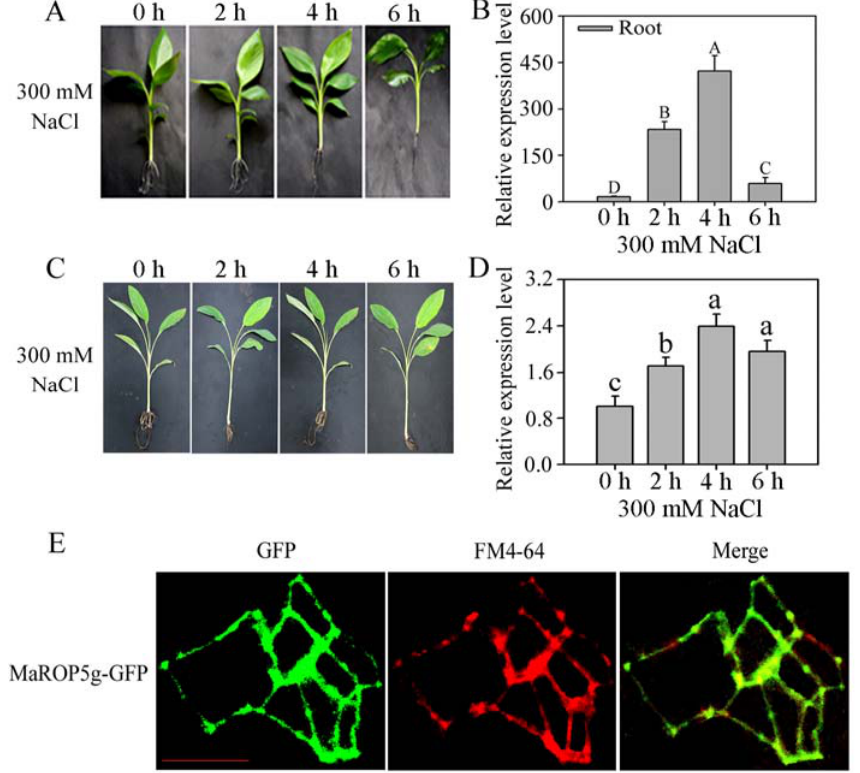
Figure 4. MaROP5g expression analyses in both banana varieties roots after different periods of exposure to salt stress and subcellular localization. ( A ) Phenotypes of BX roots exposed to salt stress; ( B ) expression of MaROP5g in BX roots exposed to salt stress; ( C ) phenotypes of FJ roots exposed to salt stress; ( D ) expression of MaROP5g in FJ roots exposed to salt stress. Data are presented as means ± standard deviations of n = 3 biological replicates. Different lowercase letters above bars indicate significant differences at p < 0.05, and different uppercase letters above bars indicate extremely significant differences at p < 0.01, using Duncan’s multiple range tests. ( E ) MaROP5g subcellular localization. GFP fluorescence is green, and FM4-64 is red. Merge was created by merging the GFP and FM4-64 fluorescent images. Scale bars = 10 μ m.